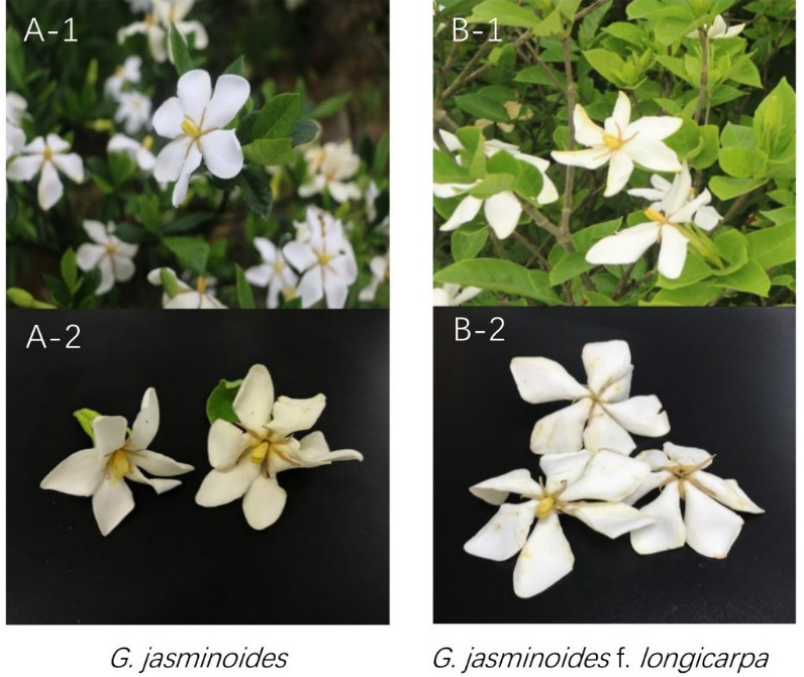
Figure 1. The flower of G. jasminoides ( A ) and G. jasminoides f. longicarpa ( B ). ( A - 1 , B - 1 ), the naturally growing flowers in the planting base in Zhejiang province. ( A - 2 , B - 2 ), the fresh flower used for essential oil extraction in the lab.